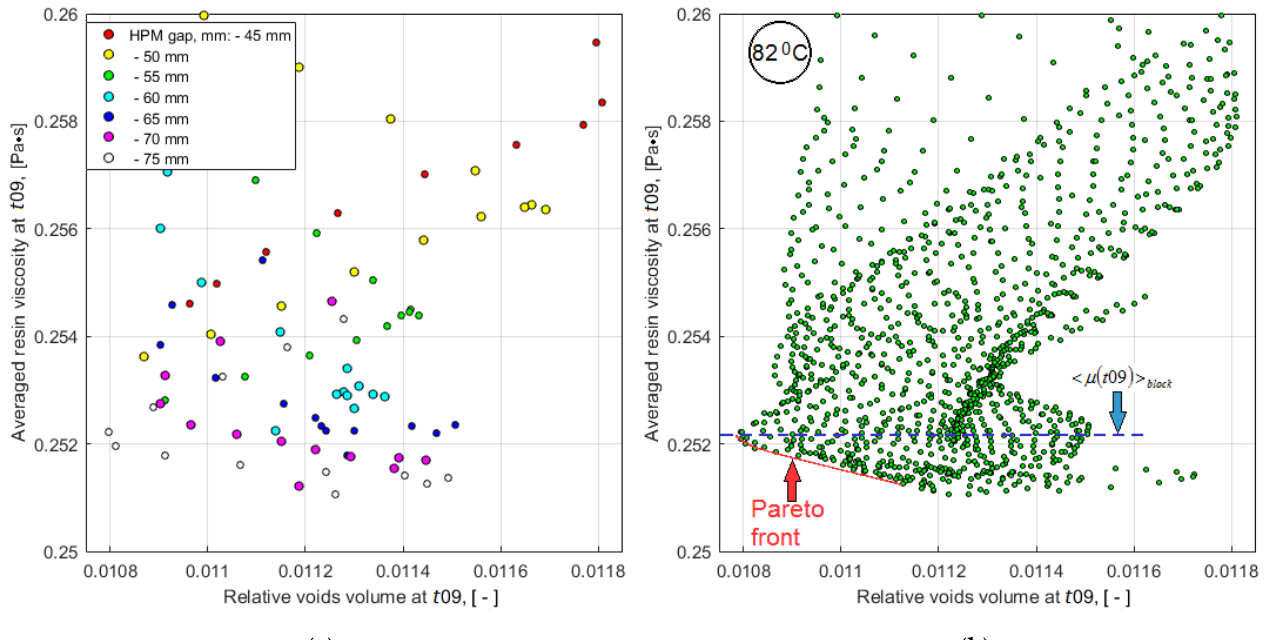
( a ) ( b ) Figure 16. The scatter plots of the evaluating predictive criteria V v ( t 09) and < µ ( t 09)>: ( a ) The results of numerical experiments carried out according to the plans shown in Figure 9; ( b ) Results of tabulation of the smoothed response functions of each criterion with a step of 1 mm in both directions for the reconstruction of the Pareto front (solid red line).